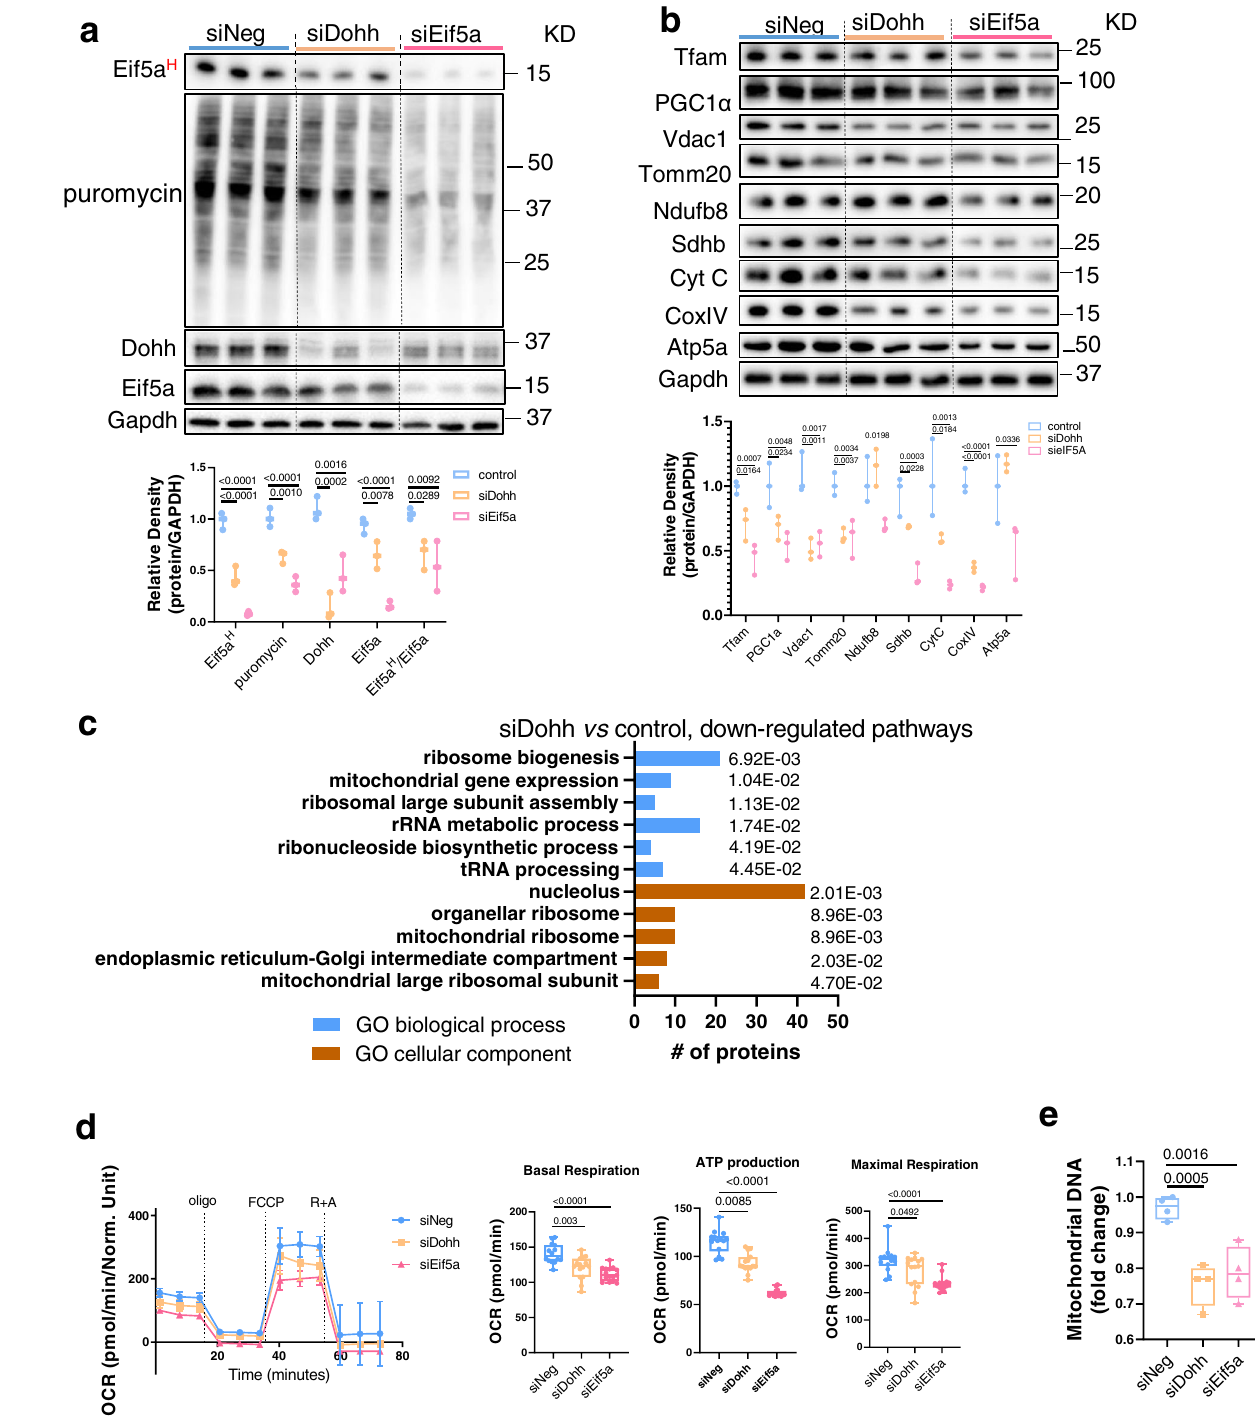
Fig. 2 | Dohh KD decreased protein synthesis and mitochondrial function in hepatic cells. AML12 cells were transfected with 20nM of negative (siNeg), Dohh (siDohh), or eIF5A (siEif5a) siRNA for 48h. Puromycin (1 µ g/ml) was added 1h before harvesting cell lysate. a Western blot and densitometric analysis of eIF5A H , and proteins after puromycin incorporation. ( n =3). b Western blot and densito- metric analysis of Tfam, PGC1 α , and mitochondrial proteins. ( n =3). c Proteomics and gene ontology (GO) enrichment analysis (with corrected p value indicated on the bar) of downregulated proteins in Dohh KD (siDohh) vs control AML12 cells. A